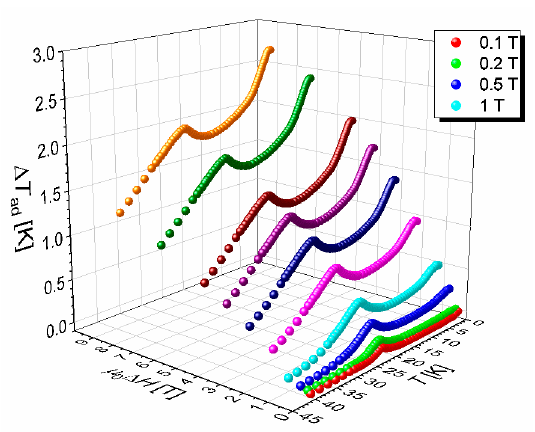
Figure 13. Temperature dependence of Δ T ad of 2 .